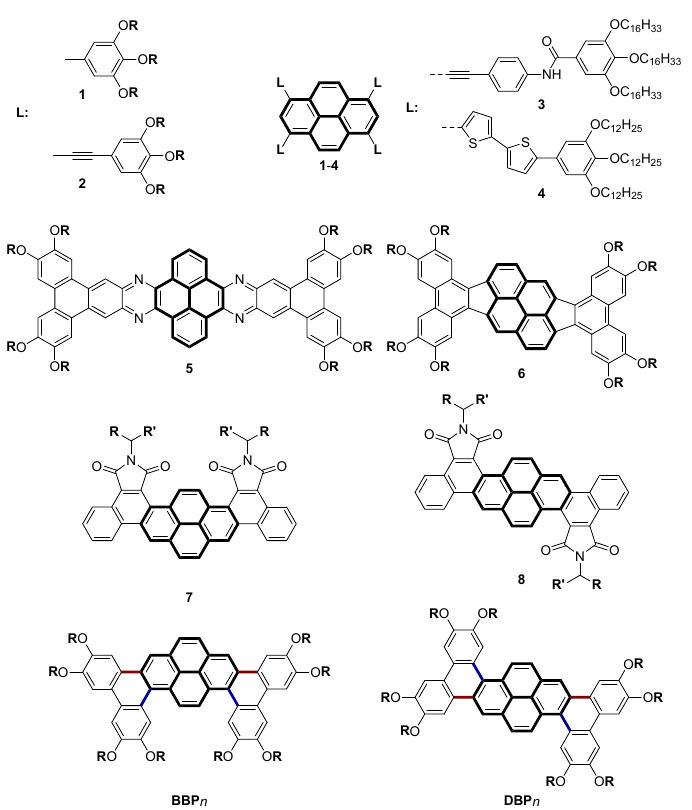
Chart 1. Various examples of pyrene ‐ containing columnar polyaromatic liquid crystals: ( 1 ) [46,47], ( 2 ) [45], ( 3 ) [8], ( 4 ) [44], ( 5 ) [58], ( 6 ) [57], and ( 7 , 8 ) [60]; BBP n and DBP n , this work (O R /O R’ = Molecules 2023 , 28 , x FOR PEER